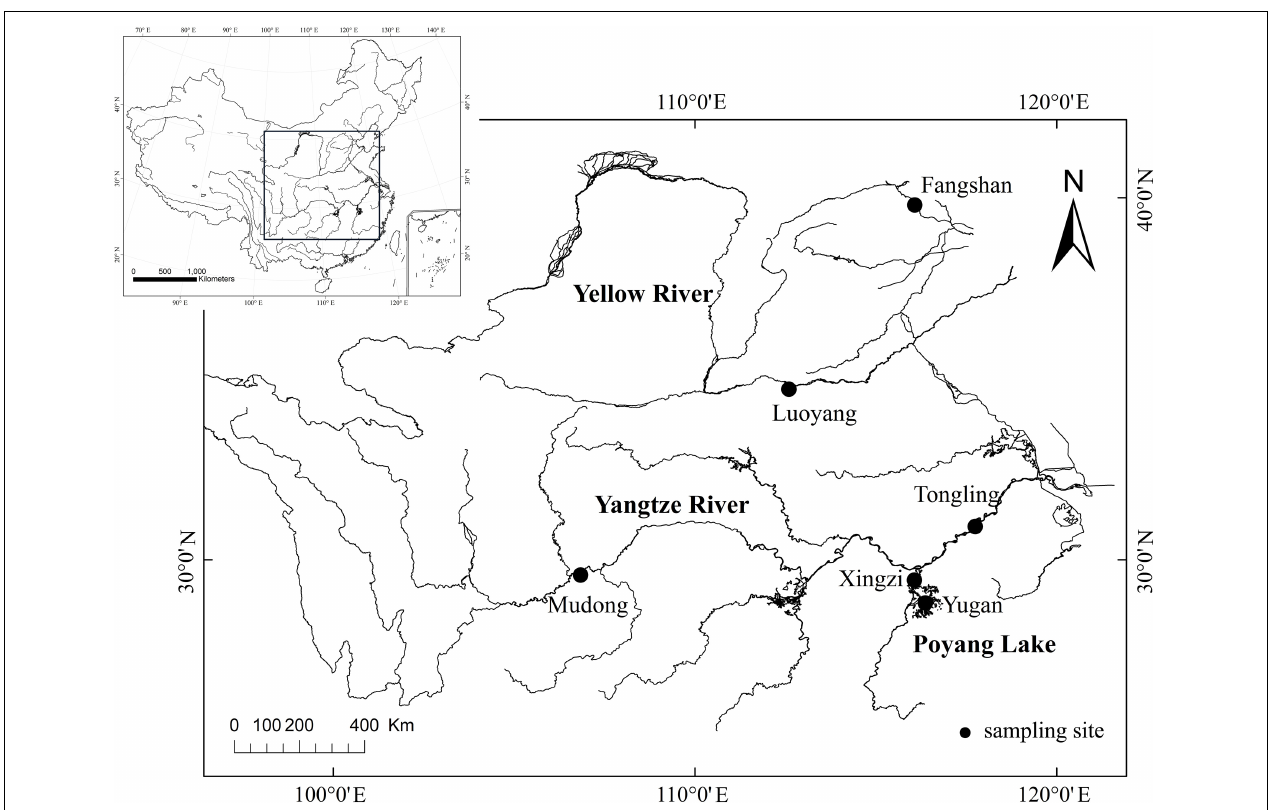
FIGURE 1 | Map of sampling locations of Hemiculter leucisculus (Fangshan, Luoyang, Mudong, Xingzi, Yugan, and